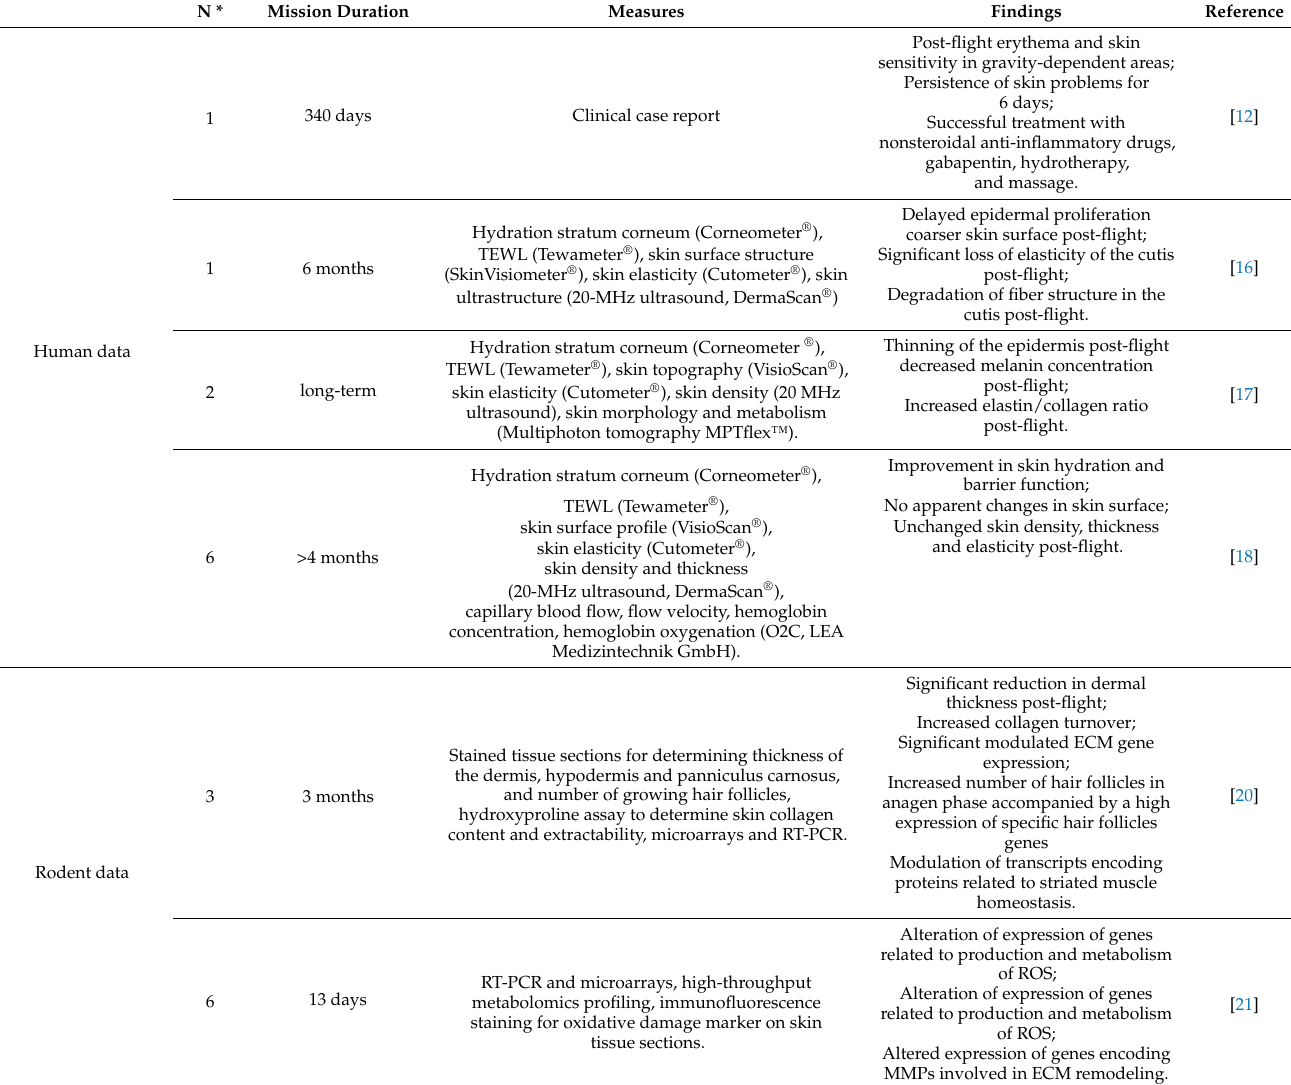
Table 1. Overview of studies measuring skin alterations during long-term